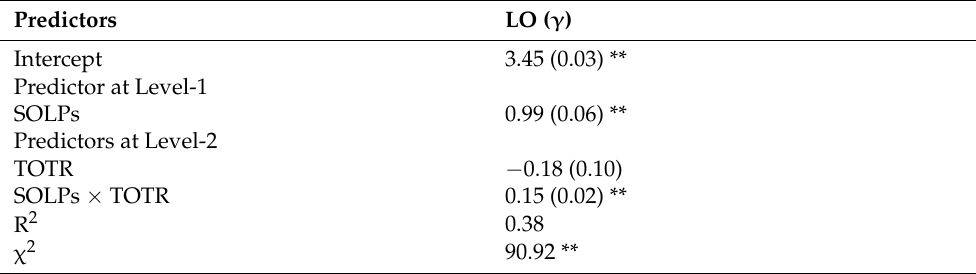
Table 6. HML results for moderating effects of TOTR (Level-2) on SOLPs and LO